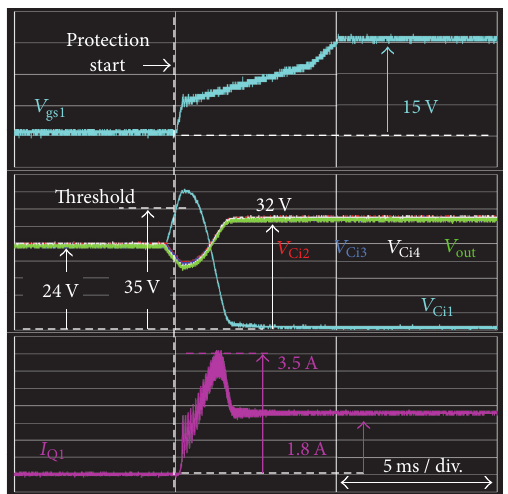
Figure 9: Measurement result of ISOP converter using 4 cell converters under fault tolerant